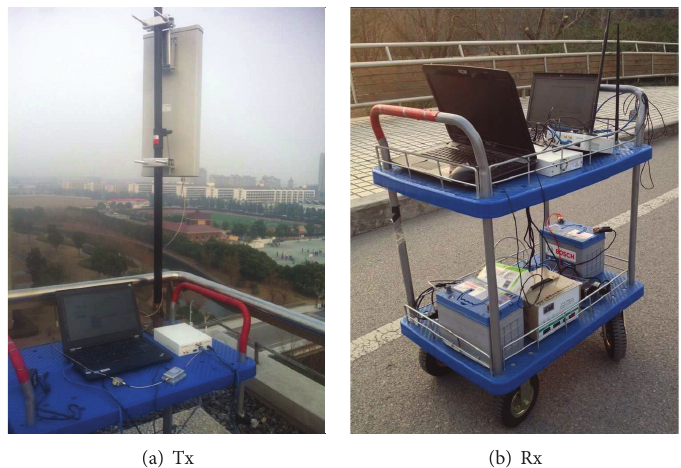
Figure 12: The photographs of the Tx and Rx in the measurement campaign.